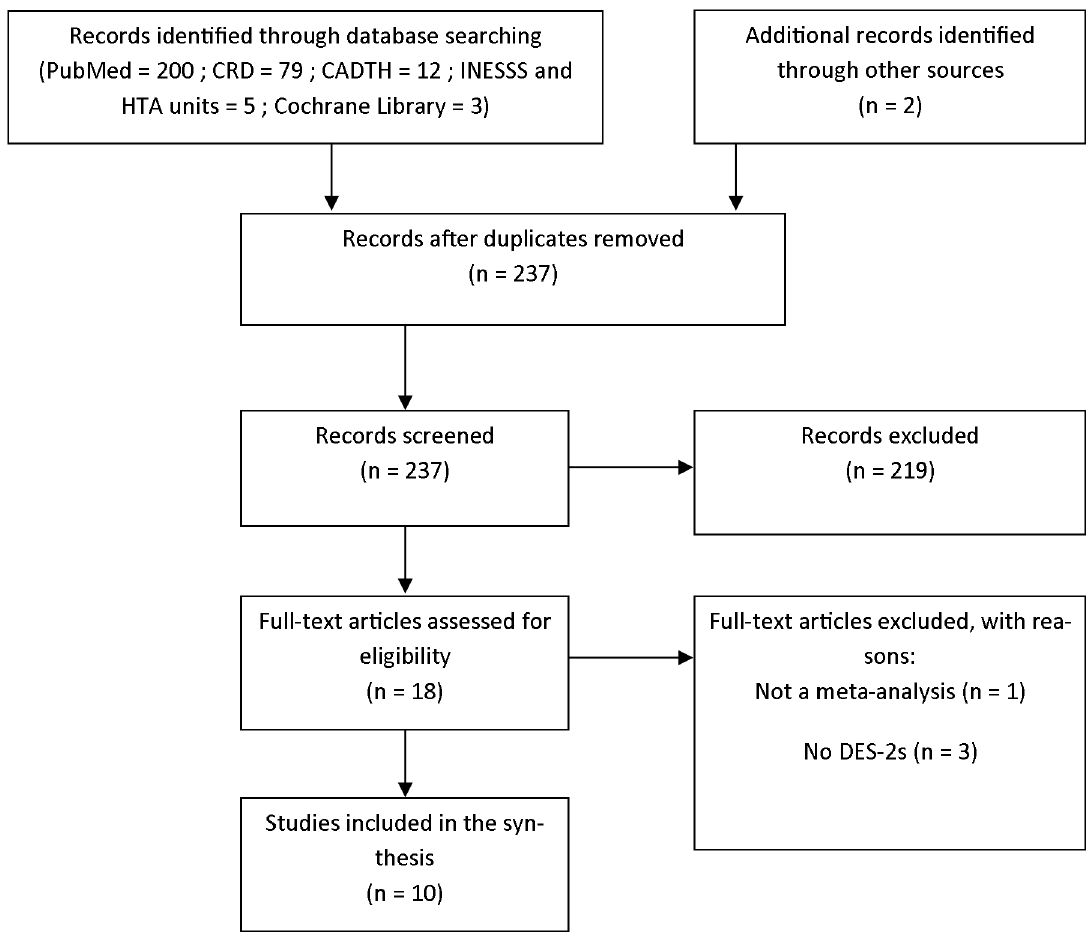
Fig 1. PRISMA flow diagram (17 august